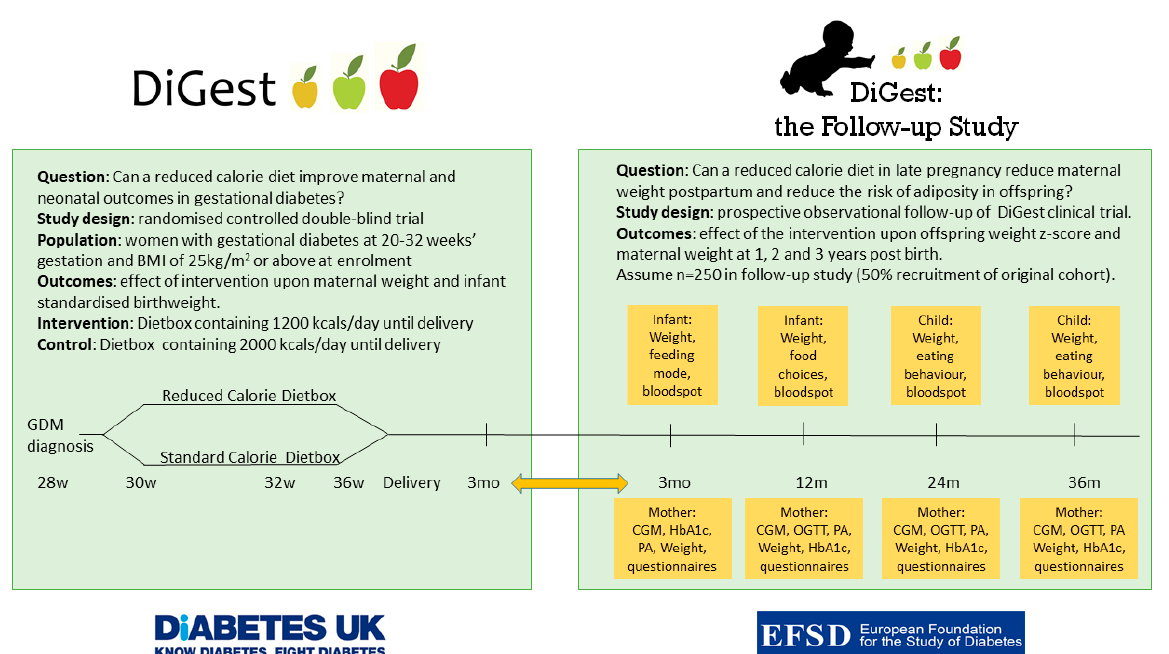
Figure 1. Summary of protocol and links between the DiGest trial and the follow up study. Anthropometry Measurements: At all visits, maternal height and weight will be measured using a routinely calibrated stadiometer and weight scale (Seca Hammer Steindamm, Birmingham, U.K.). Waist and hip circumference will be measured to the nearest 0.1 cm with a fibreglass tape, in accordance with the World Health Organisation criteria [19]. Waist circumference is located at the midpoint between the lowest palpable rib and the iliac crest. Hip circumference is measured at the greater trochanters, or at the widest extension of